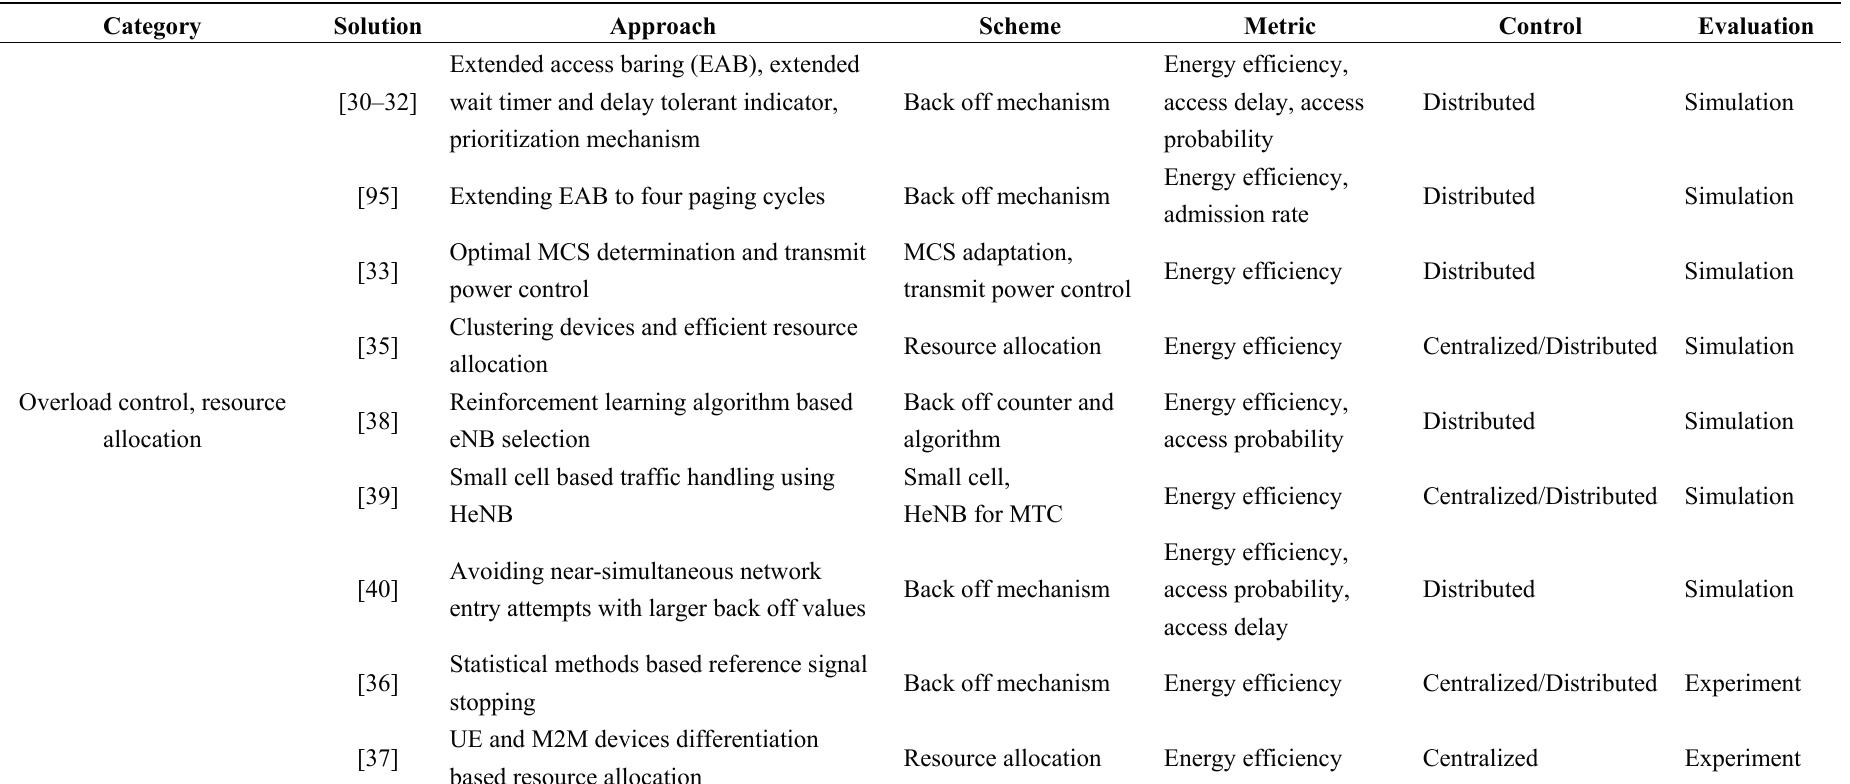
Table 1. Energy conserving solutions for wireless wide area network (e.g., 3GPP)-based